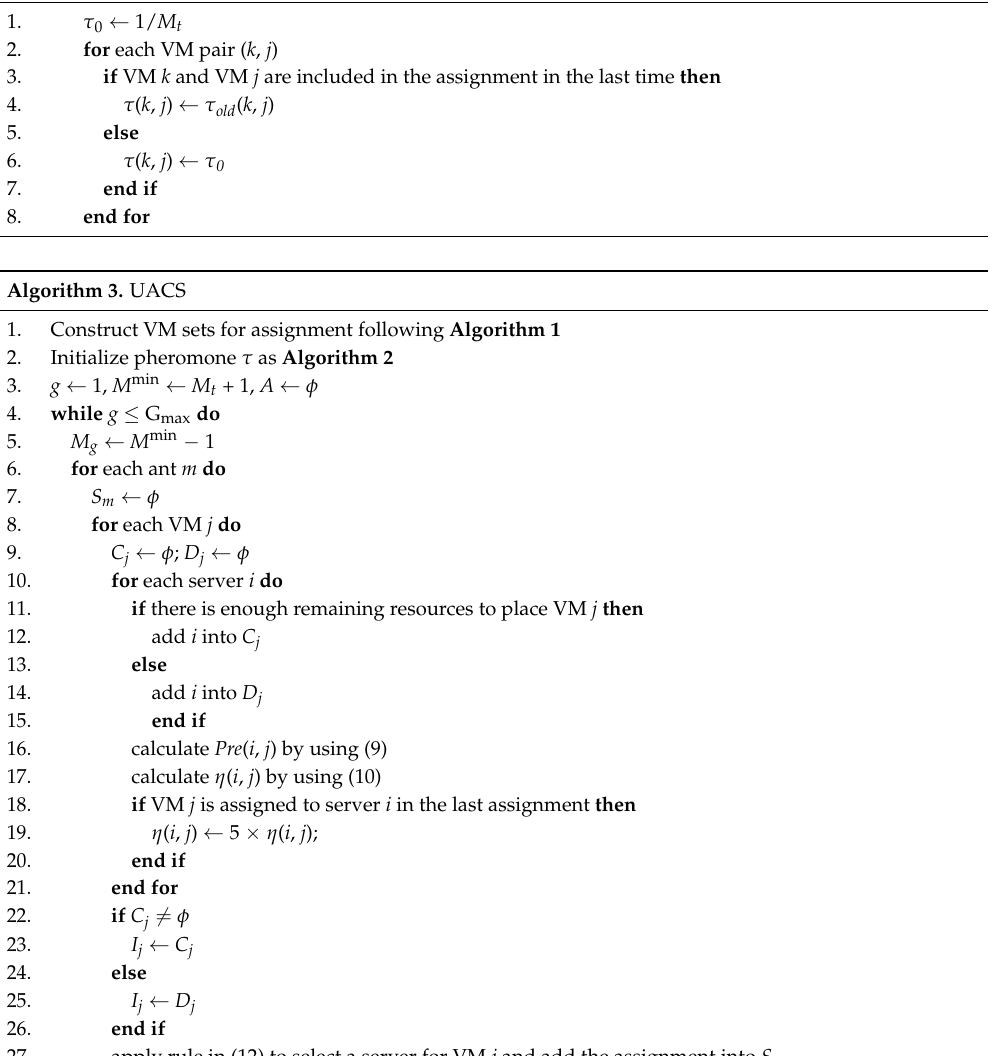
Algorithm 2. Initialize Pheromone Deposition